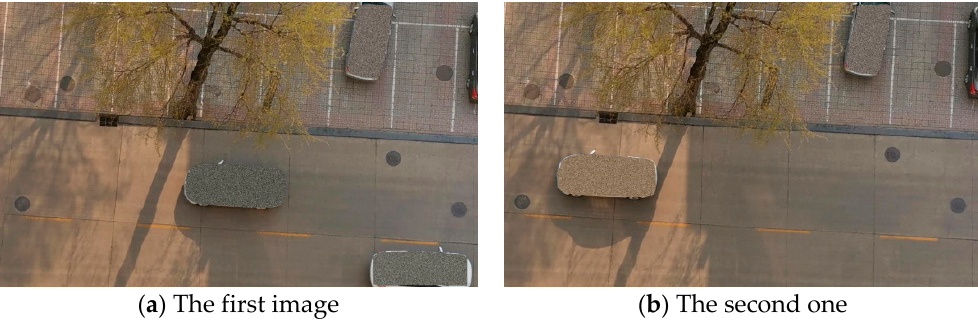
Figure 6. Cover the objects with similar color.